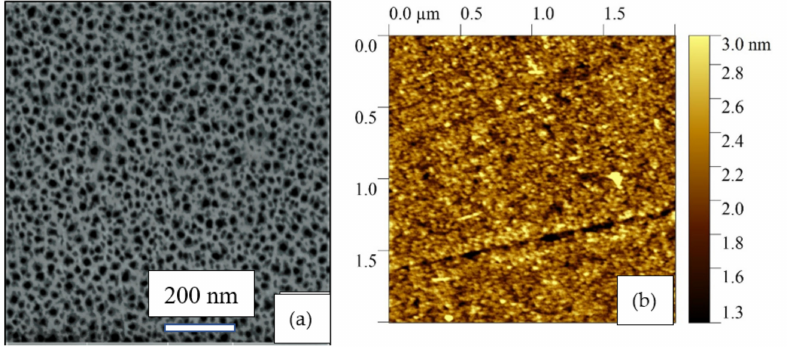
Figure 3. Surface of p-type silicon wafers with resistance (cid:36) v = 0.002 Ohm cm after NPSi formation. Images obtained with SEM-( a ) and AFM-( b ).